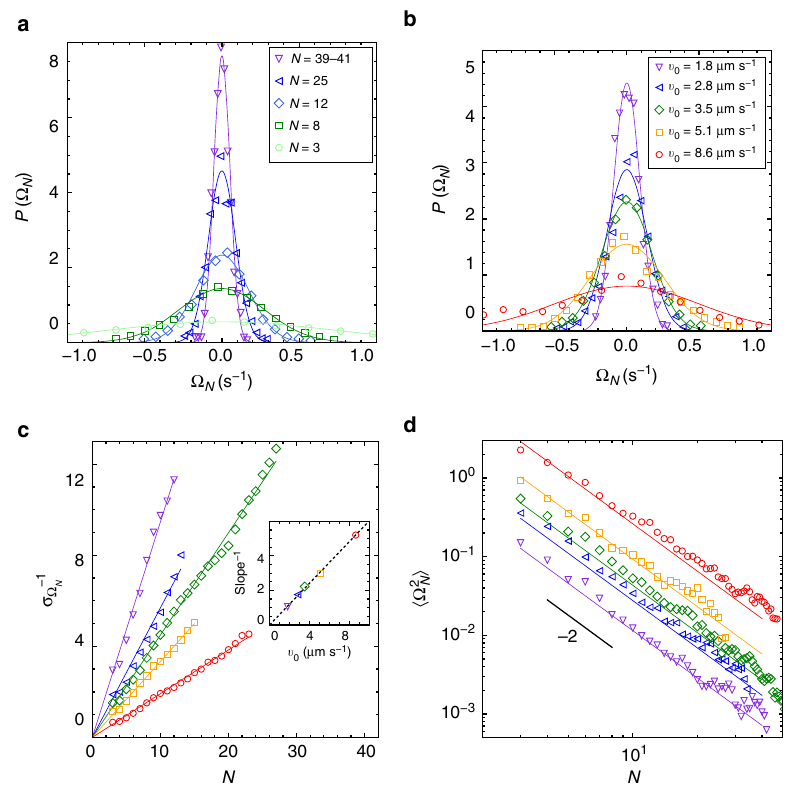
Fig. 4 Rotational dynamics of individual clusters. a , b PDF for the rotational velocity Ω N of a cluster of size N , for fi xed activity v 0 = 3.1 μ m s − 1 and various cluster sizes, and for a fi xed cluster size ( N = 12) and different activities. Symbols: experimental data and solid lines: theoretical fi ts according to a Gaussian, yielding σ Ω . c , d Variance and mean square of rotational velocities as a function of size and activity (inset). Symbols: experimental data for different N activities and solid line: random orientation model Eq.